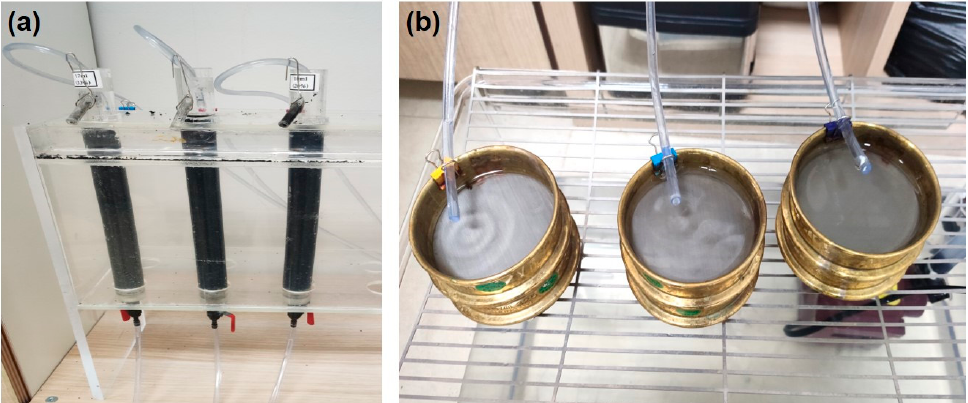
Figure 1. The columns filled with granular activated carbon (GAC) used in the experiments ( a ). Larvae that passed through GAC column were confirmed by filtering using sieves ( b ).